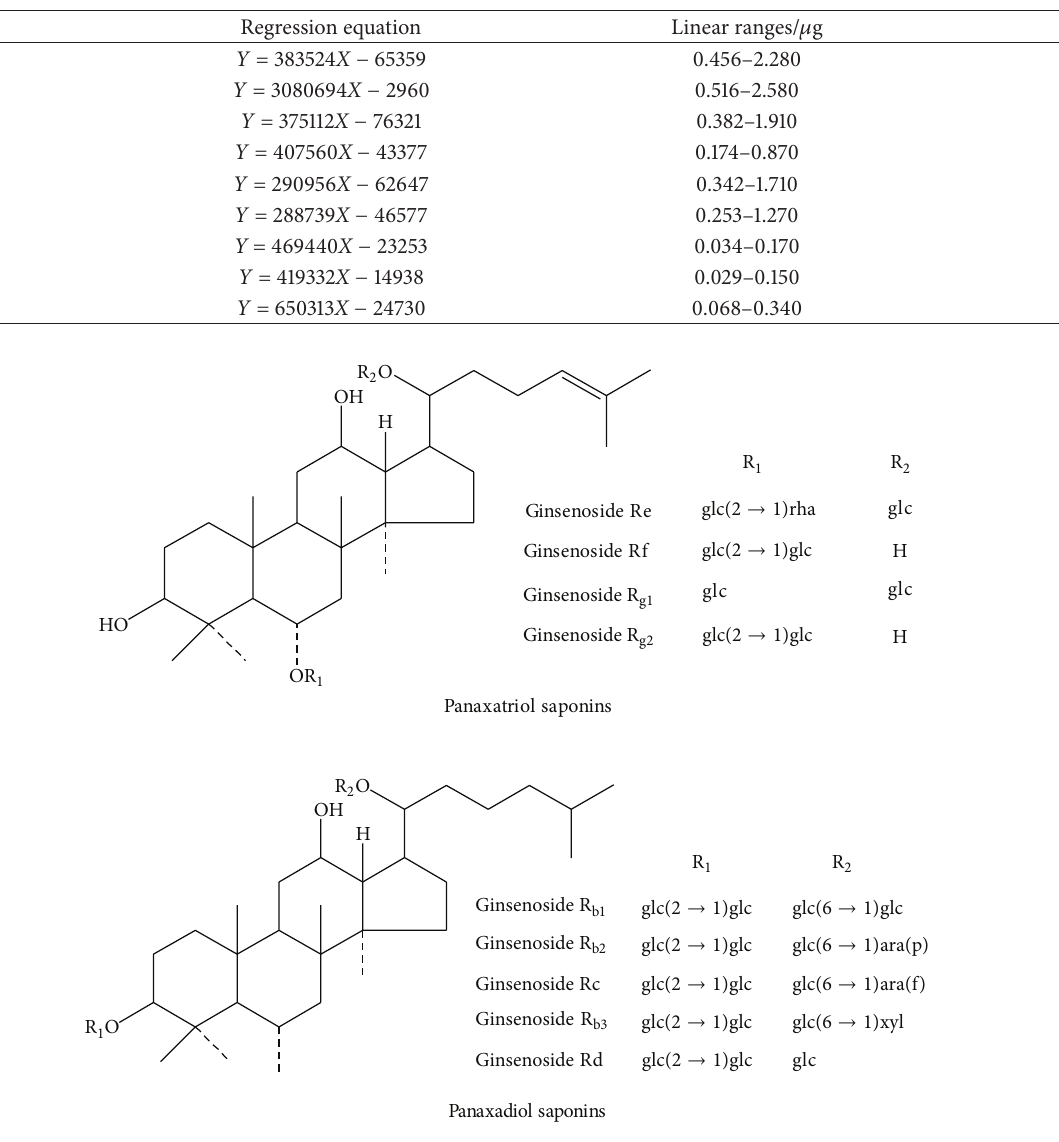
Table 1: The linear regression equations of nine ginsenosides.